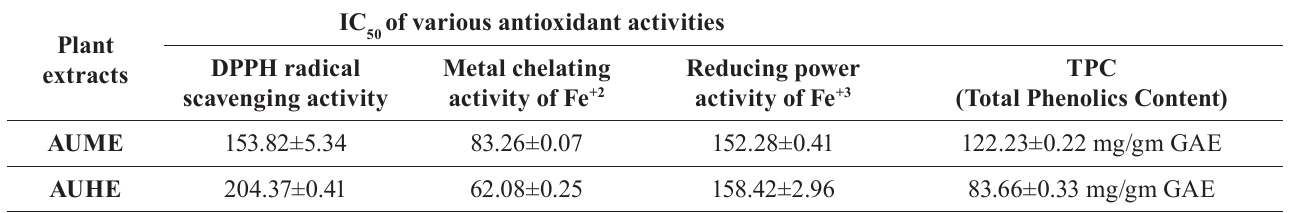
TABLE VI A - IC of antioxidant activities and TPC of plant extracts of whole plant of A. uliginosa 50